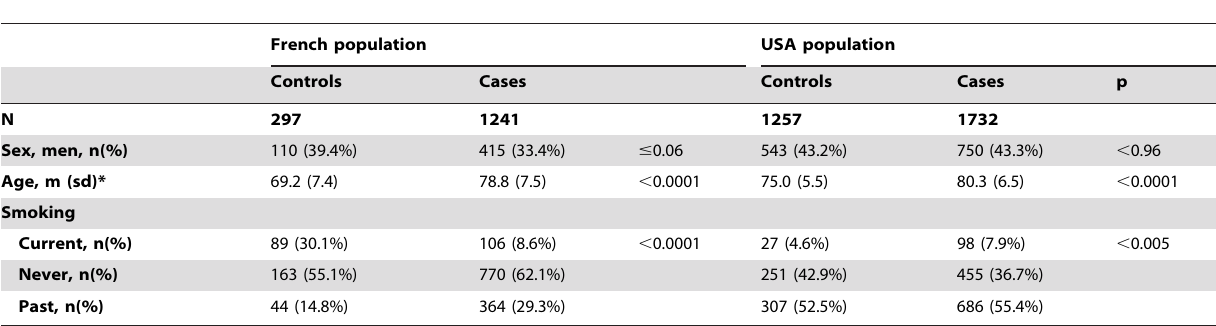
Table 1. Non-genetic characteristics of the entire French and North American populations.